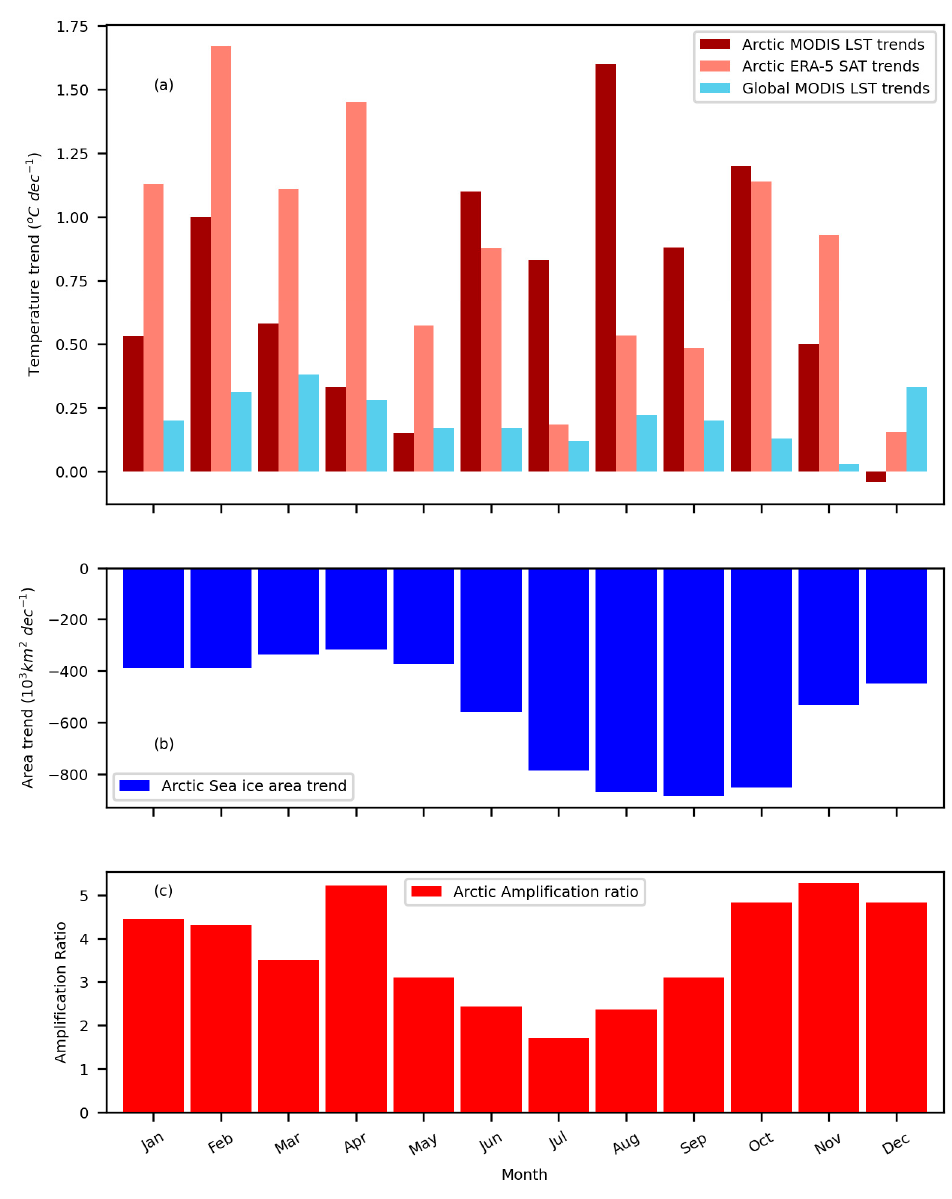
Figure 6. Monthly variations in Arctic climate trends. ( a ) Land temperature (LST) trends from MODIS LST data set and the surface air temperature trend from ERA-5 reanalysis from 2001–2020 [40]. ( b ) Sea ice area trends from 1979–2019 [113]. ( c ) Arctic amplification ratio from 1979–2021 averaged over three observational data sets (Berkeley Earth, Gistemp, HadCRUT5) and the ERA5 reanalysis [34].